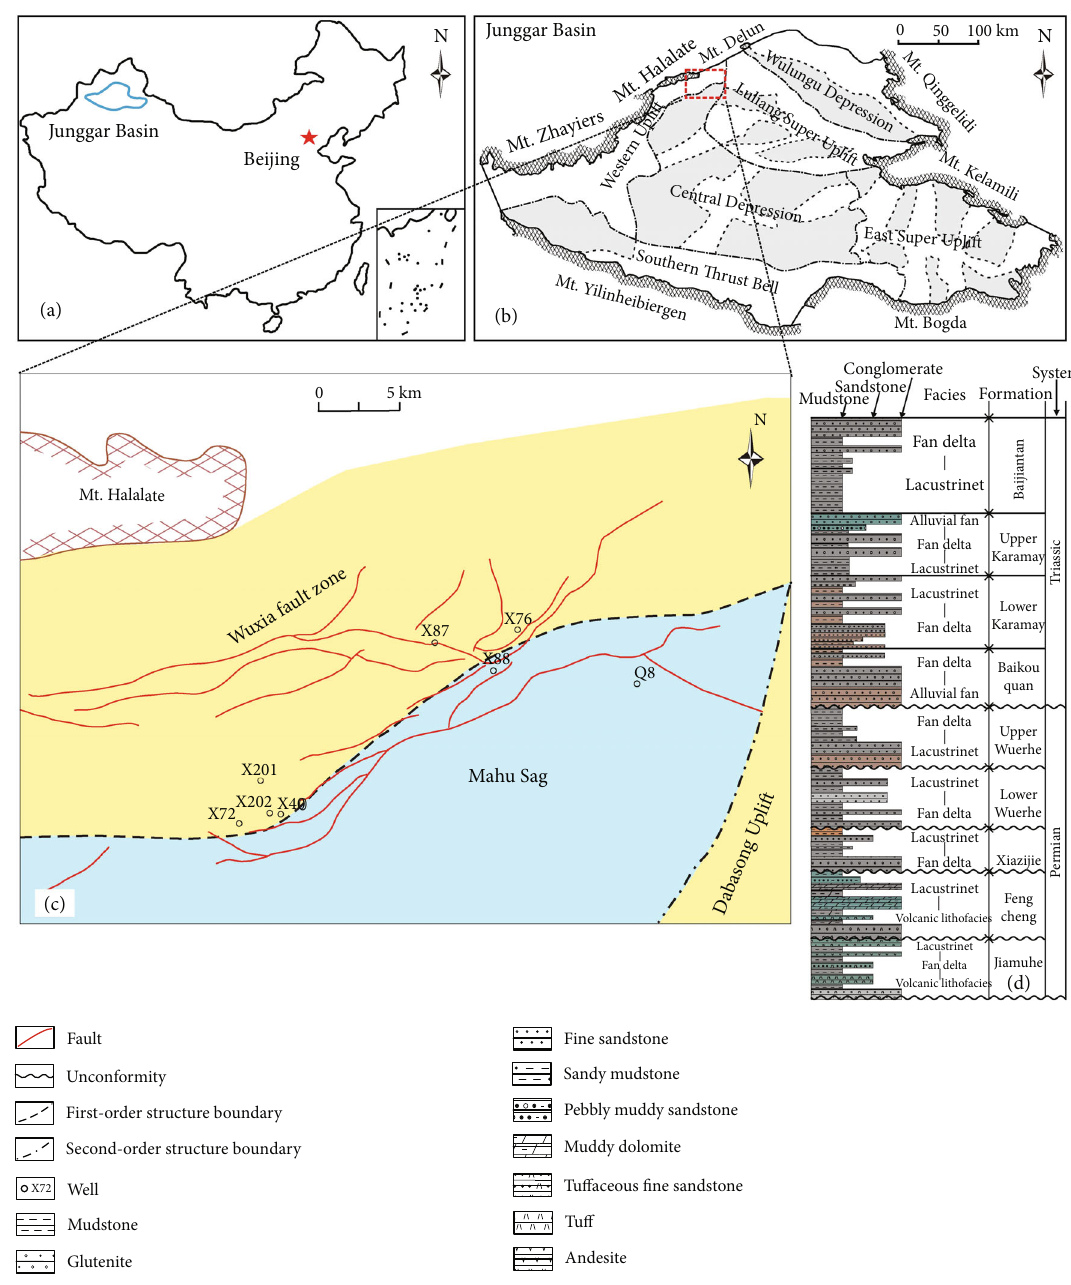
Figure 1: (a) Geographical location of Junggar Basin in China. (b) Tectonic units of the Junggar Basin. (c) Geographical location of Wuxia region. (d) Lithological